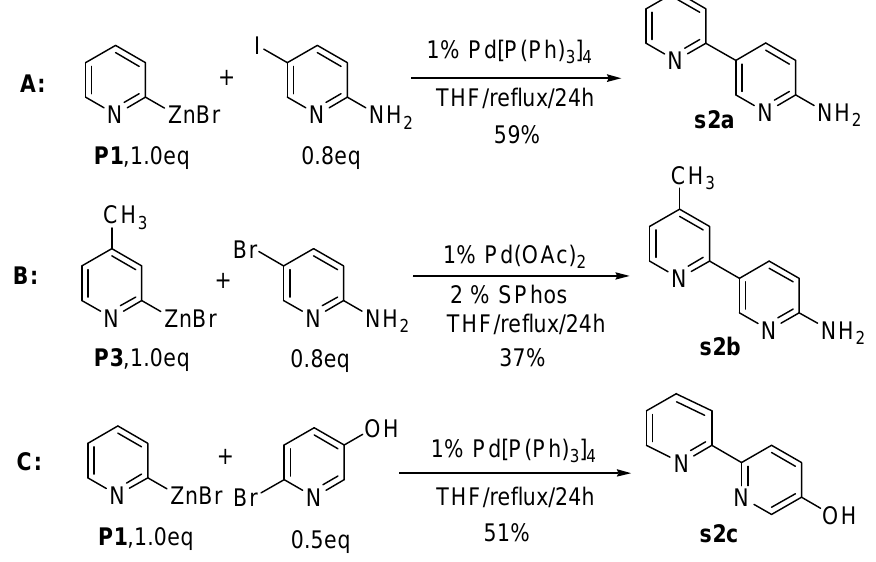
Scheme 2. Preparation of amino and hydroxyl